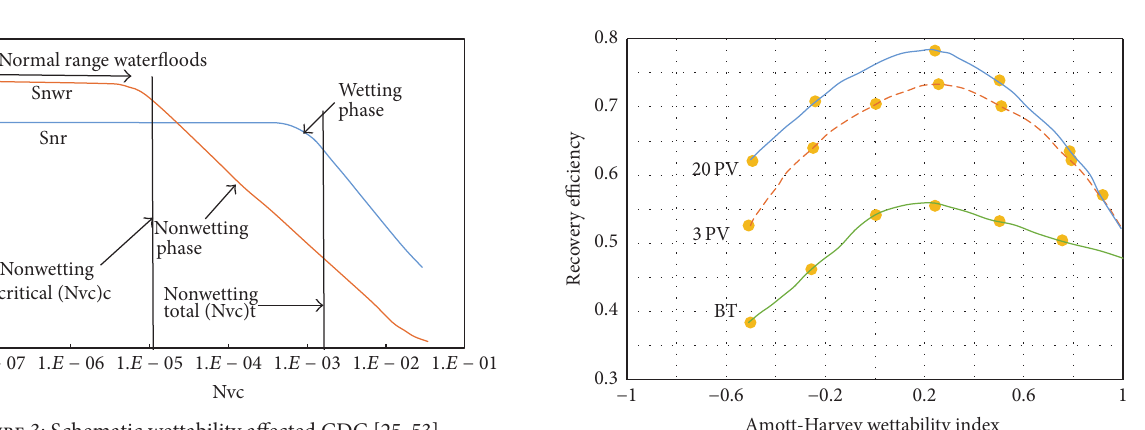
Figure 3: Schematic wettability affected CDC [25, 53]. some equation contains a factor of cos 𝜃 . Herein 𝜃 is wet- ting angle, but this is invalid in mixed wetting. Systems